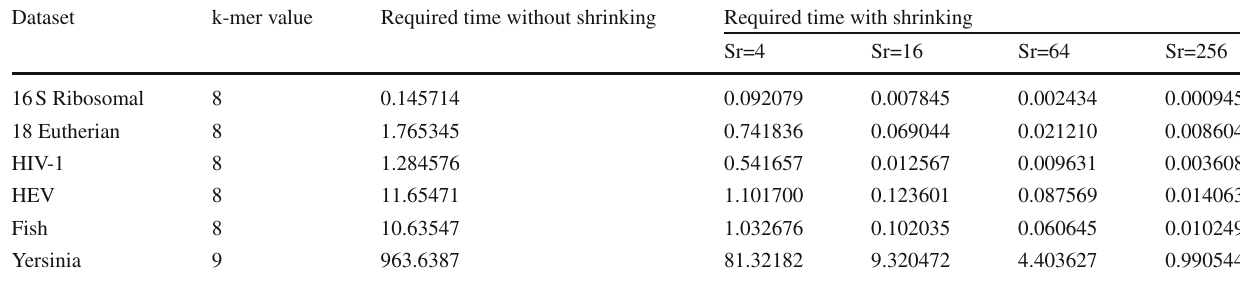
Table 12 Impact analysis of proposed shrinking algorithm in terms of time complexity